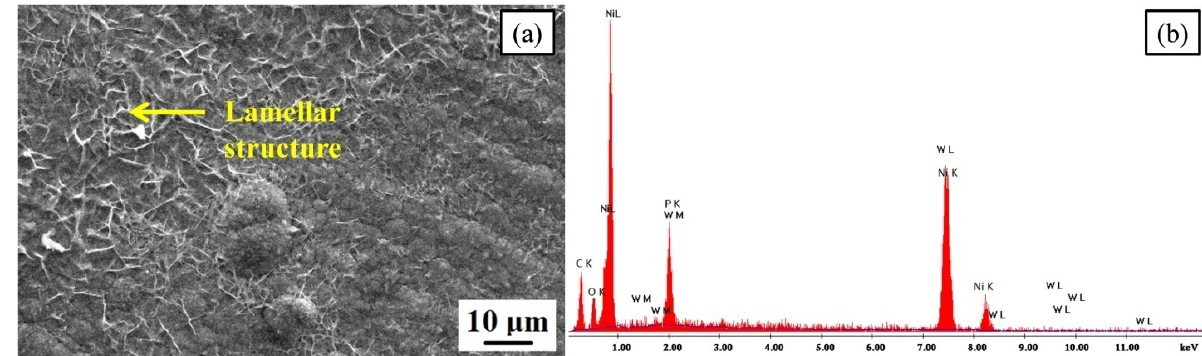
Figure 13. (a) SEM image and (b) EDS of corroded Ni-P-W coated rebar for the bath parameter combination at optimal